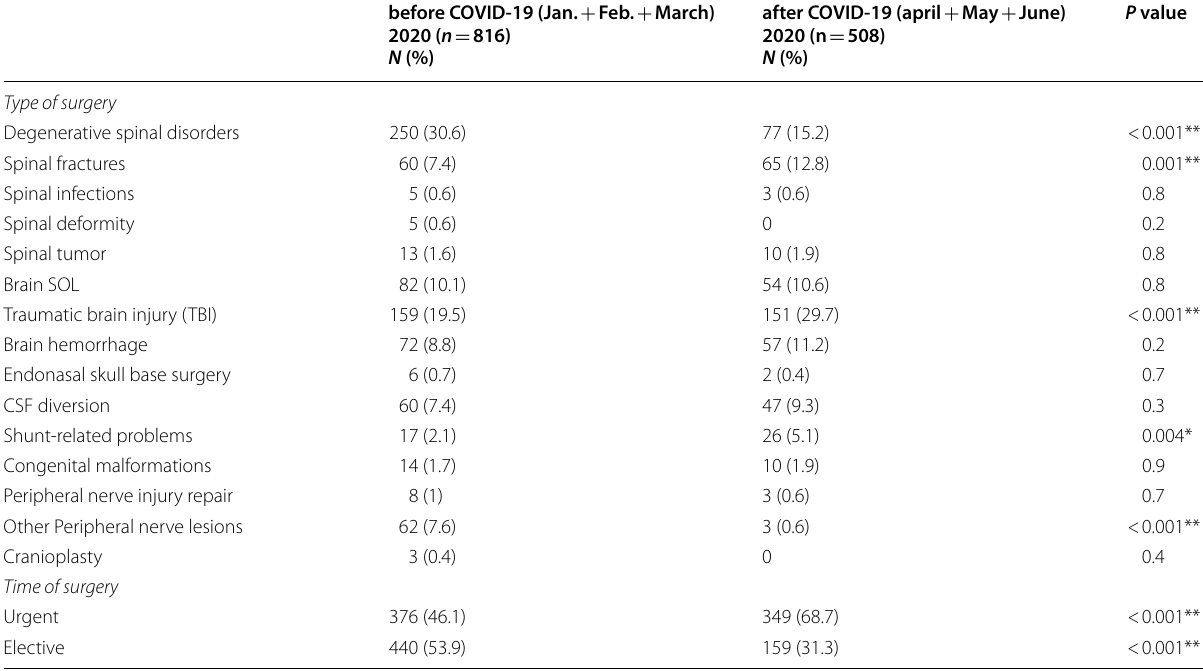
Table 5 Neurosurgical operations before and after the lockdown